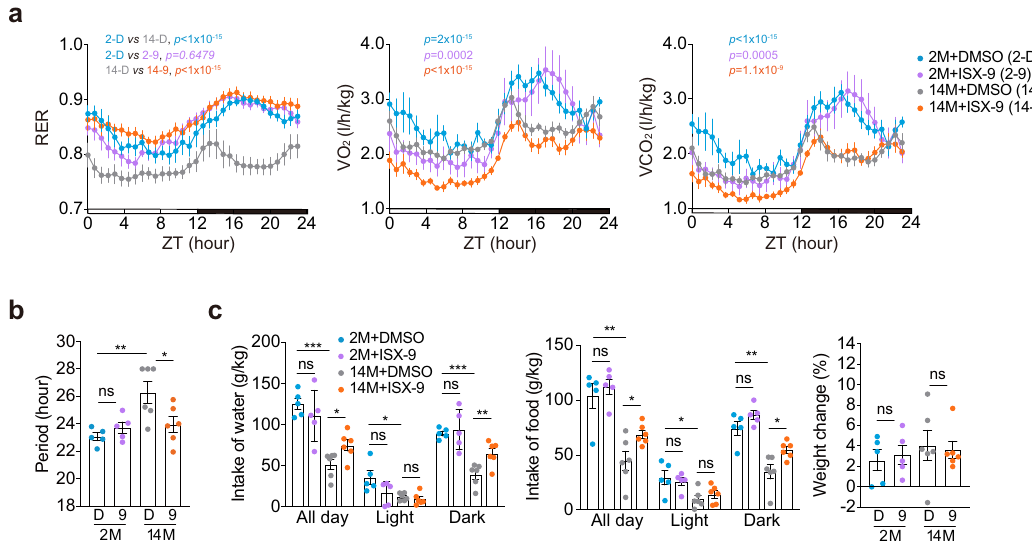
Fig. 3 ISX-9 rejuvenated metabolic oscillations in middle-aged mice. a Respiratory exchange ratio (RER), oxygen consumption (VO 2 ), CO 2 production (VCO 2 ) of male 2-month-old mice treated with DMSO (blue curve, n = 5) or ISX-9 (purple curve, n = 5) versus male 14-month-old mice with DMSO (gray curve, n = 6) or ISX-9 (orange curve, n = 6). All data were represented as mean ± SEM. Two-way ANOVA with Bonferroni correction for multiple comparison was performed, and the p values between indicated groups were listed on top. b Period of RER fl uctuation from the metabolic cage data, processed with the software ClockLab. c Analysis of daily water intake, food consumption, and body weight change in the same mouse cohorts as in Fig.